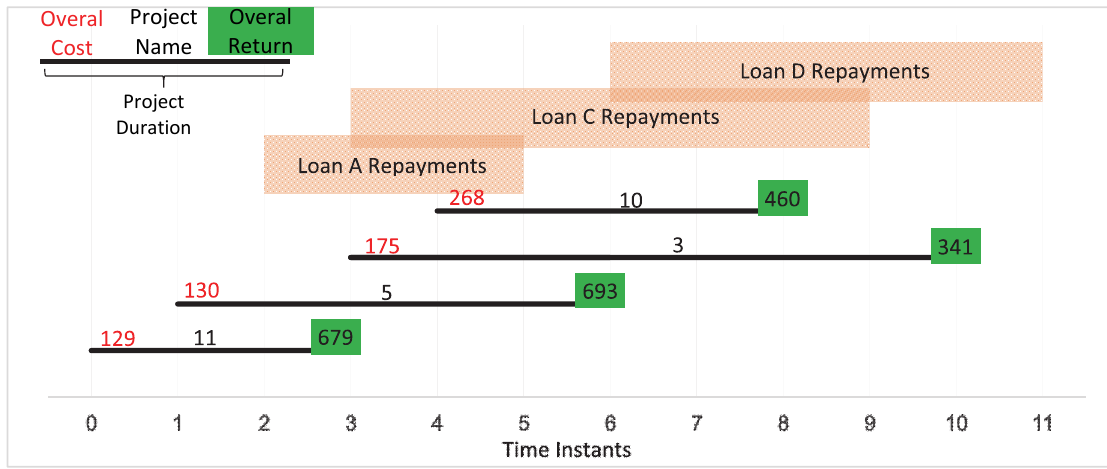
Fig. 5 . Portfolio schedule in absence of